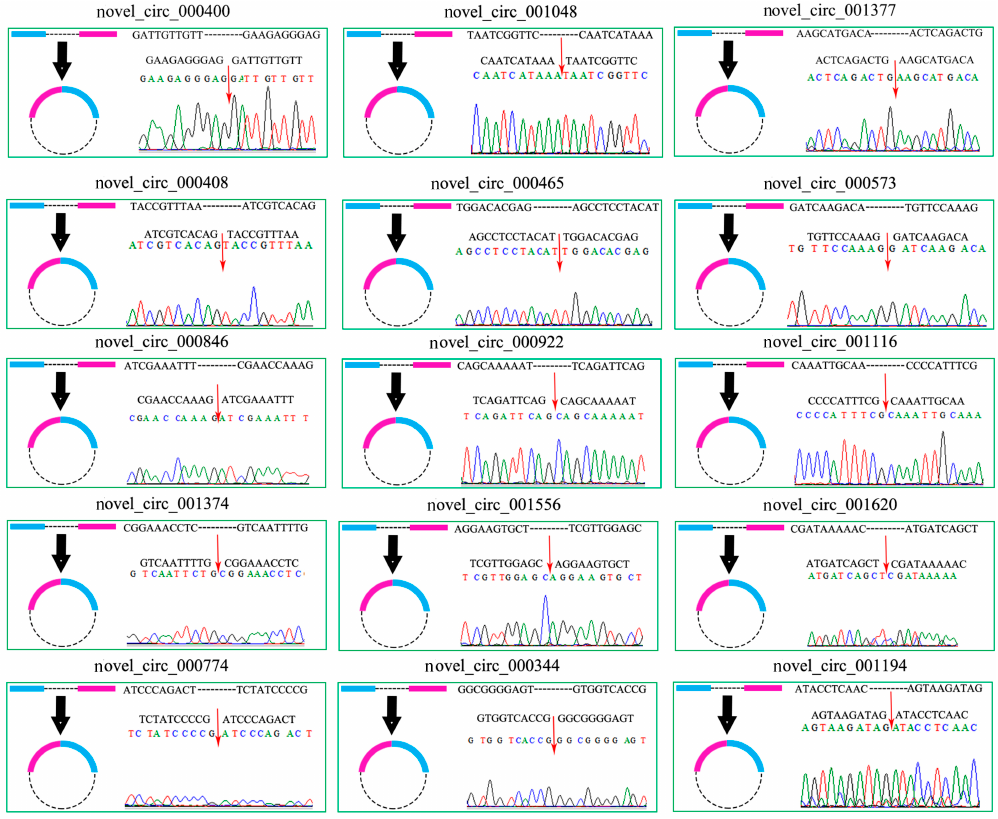
Figure 7. The Sanger sequencing of the amplified fragments from 15 A. m. ligustica circRNAs. The red arrows indicate the back-splicing sites.